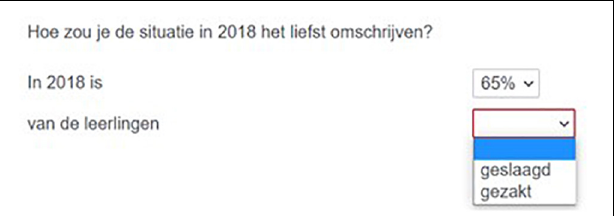
FIGURE 3 | Screen shot of the answering format in the static task (experiment 1). Translation: How would you prefer to describe the situation in 2018? In 2018 (35%) 65% of the pupils ... passed/failed. Note: this translation is a gloss of the Dutch word order.